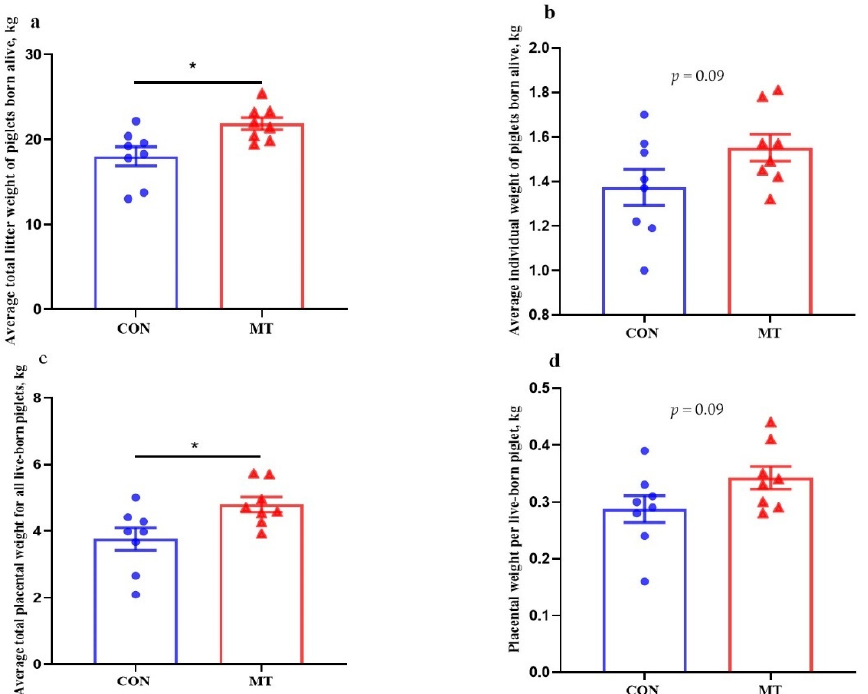
Figure 1. Effects of maternal MT supplementation during gestation on litter performance and placental weights. ( a ) Average total litter weight of piglets born alive. ( b ) Average individual weight of piglets born alive. ( c ) Average total placental weight for all live-born piglets. ( d ) Placental weight per live-born piglet. Data are presented as means ± SEM, n = 8. * p < 0.05. CON = control, MT = melatonin.